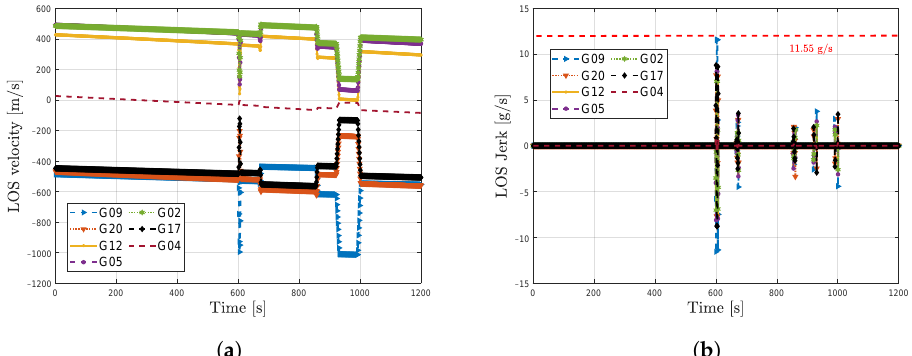
Figure 9. LOS dynamics in simulated dynamic scenario. ( a ) LOS velocity dynamics. ( b ) LOS jerk dynamics. Table 2. Tracking applications under evaluation. The tracking configurations used for each applica- tion are marked with x.